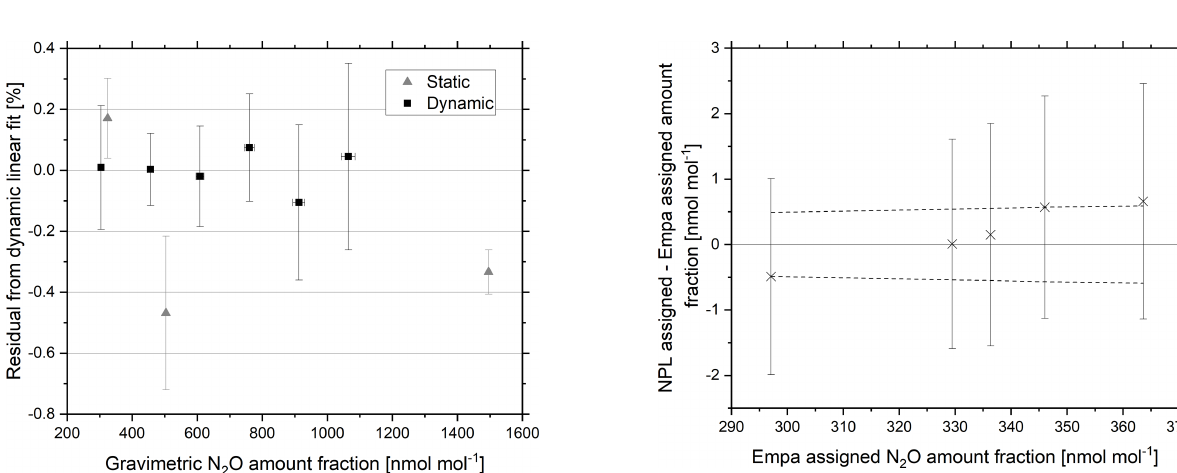
Figure 7. Residuals from the linear regression of analyser response with increasing gravimetric amount fraction of the dynamic refer- ence materials. Static (triangles) and dynamic (squares) reference materials in the amount fraction range 300–1500nmolmol − 1 N 2 O in synthetic air. Error bars represent the gravimetric uncertainty ( k = 2) ( x axis) and the percent reproducibility between the four repetitions of a 5min average ( y axis).